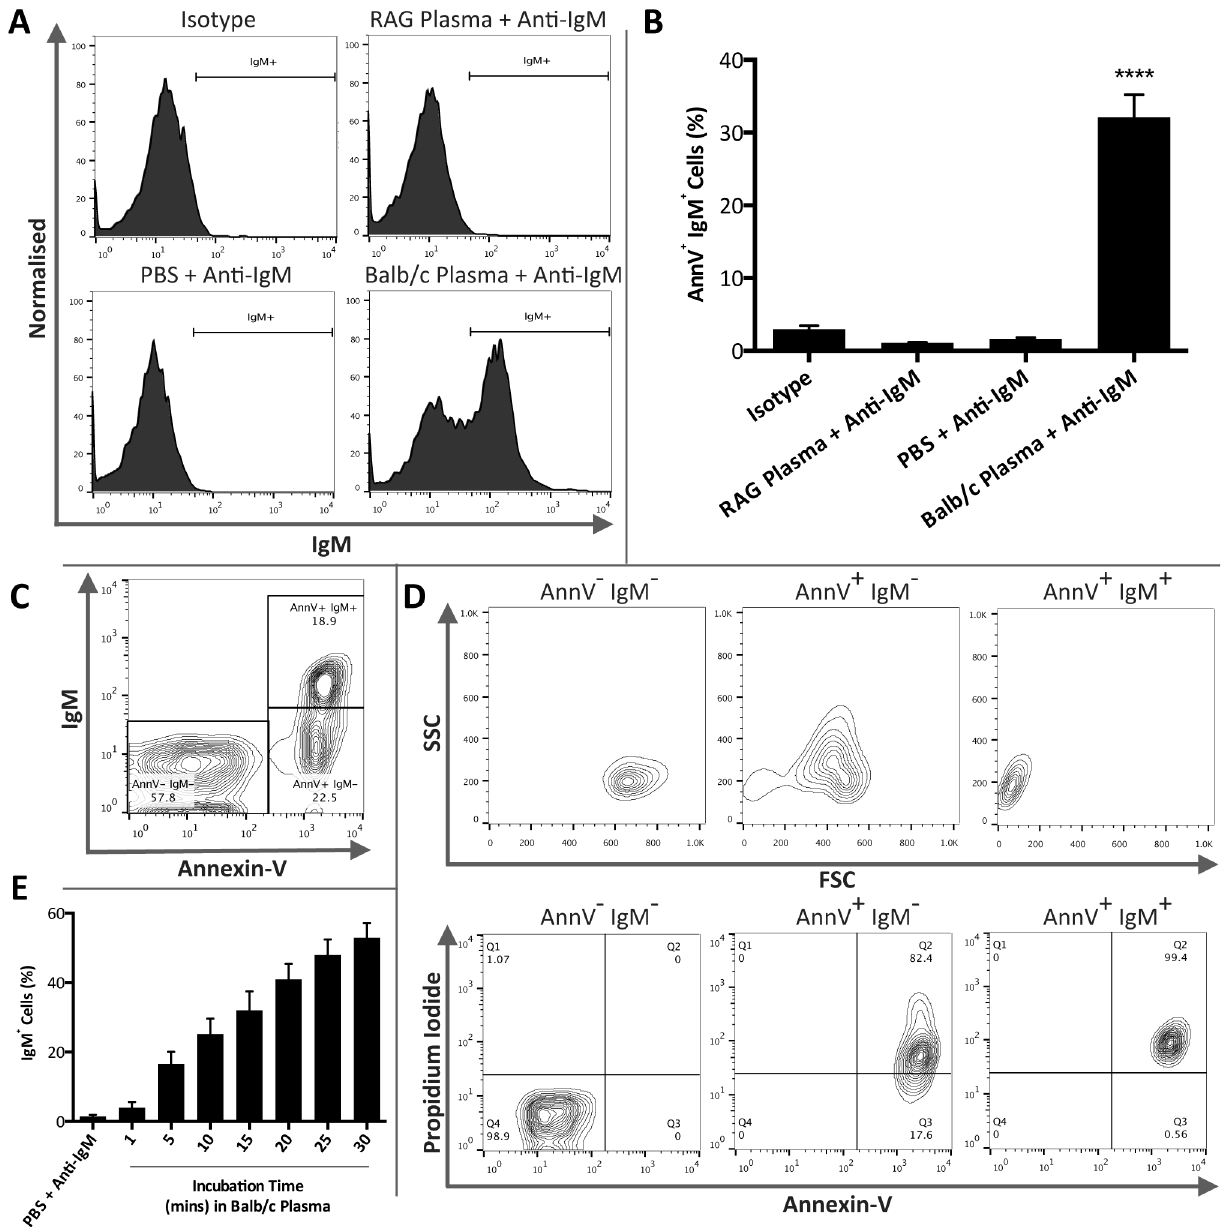
Fig 1. IgM rapidly and specifically binds to a distinct population of AnnV + PI + mouse thymocytes. Mouse thymocytes were rendered apoptotic by overnight culture. Thymocytes were then exposed to either mouse anti-human isotype control antibodies (mouse (Balb/c) IgM κ isotype control), PBS, Balb/c plasma (as a source of IgM) or plasma from immunodeficient RAG1-deficient mice. IgM binding was then assessed by flow cytometry. Annexin-V (AnnV) and propidium iodide (PI) staining, assessed by flow cytometry, was used to determine the level of non-apoptotic (AnnV - PI - ), early (AnnV + PI - ) or late apoptotic (AnnV + PI + ) thymocytes. A ) Representative histograms illustrating IgM binding to AnnV + apoptotic thymocytes within treatment groups. B ) Apoptotic thymocytes were gated on the basis of AnnV positivity and the percentage of AnnV + IgM + thymocytes was assessed. IgM binding in isotype, RAG1-deficient mice plasma and PBS treatment groups remained non-significant whilst samples exposed to Balb/c plasma exhibited significant binding (Kruskal – Wallis one-way ANOVA; P < 0.0001). However, surprisingly approximately 68% were IgM - . C ) Samples exposed to Balb/c plasma consisted of three distinct populations: AnnV - IgM - , AnnV + IgM - and AnnV + IgM + . D ) The three distinct populations present in samples exposed to Balb/c plasma were further characterised by examining the FSC/SSC profile and AnnV and PI positivity. Although both AnnV + IgM - and AnnV + IgM + populations were predominantly AnnV + PI + they occupied distinct separate regions of FSC/SSC contour plots. E ) Within the AnnV + IgM + population IgM binding occurred rapidly ( n = 4). Data representative of n = 5 isotype, n = 6 RAG1 deficient mice plasma + Anti-IgM, n = 8 PBS + Anti-IgM and n = 8 Balb/c plasma + Anti-IgM. Data expressed as means ± SEM.